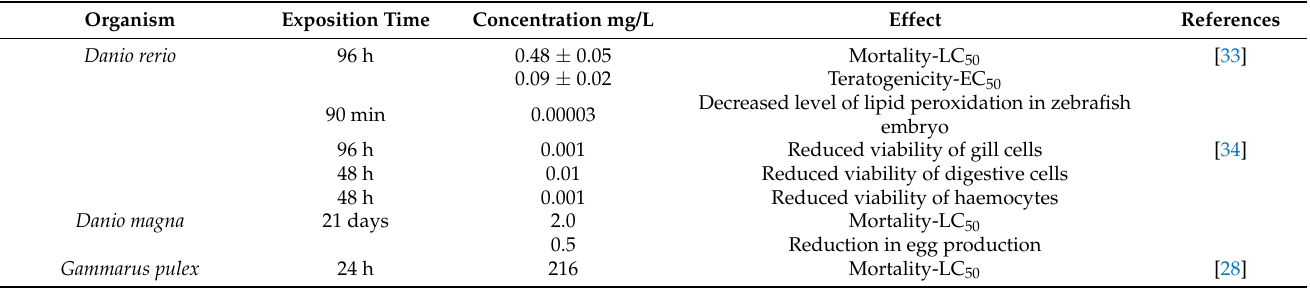
Table 2. Toxicity of diclofenac to non-target